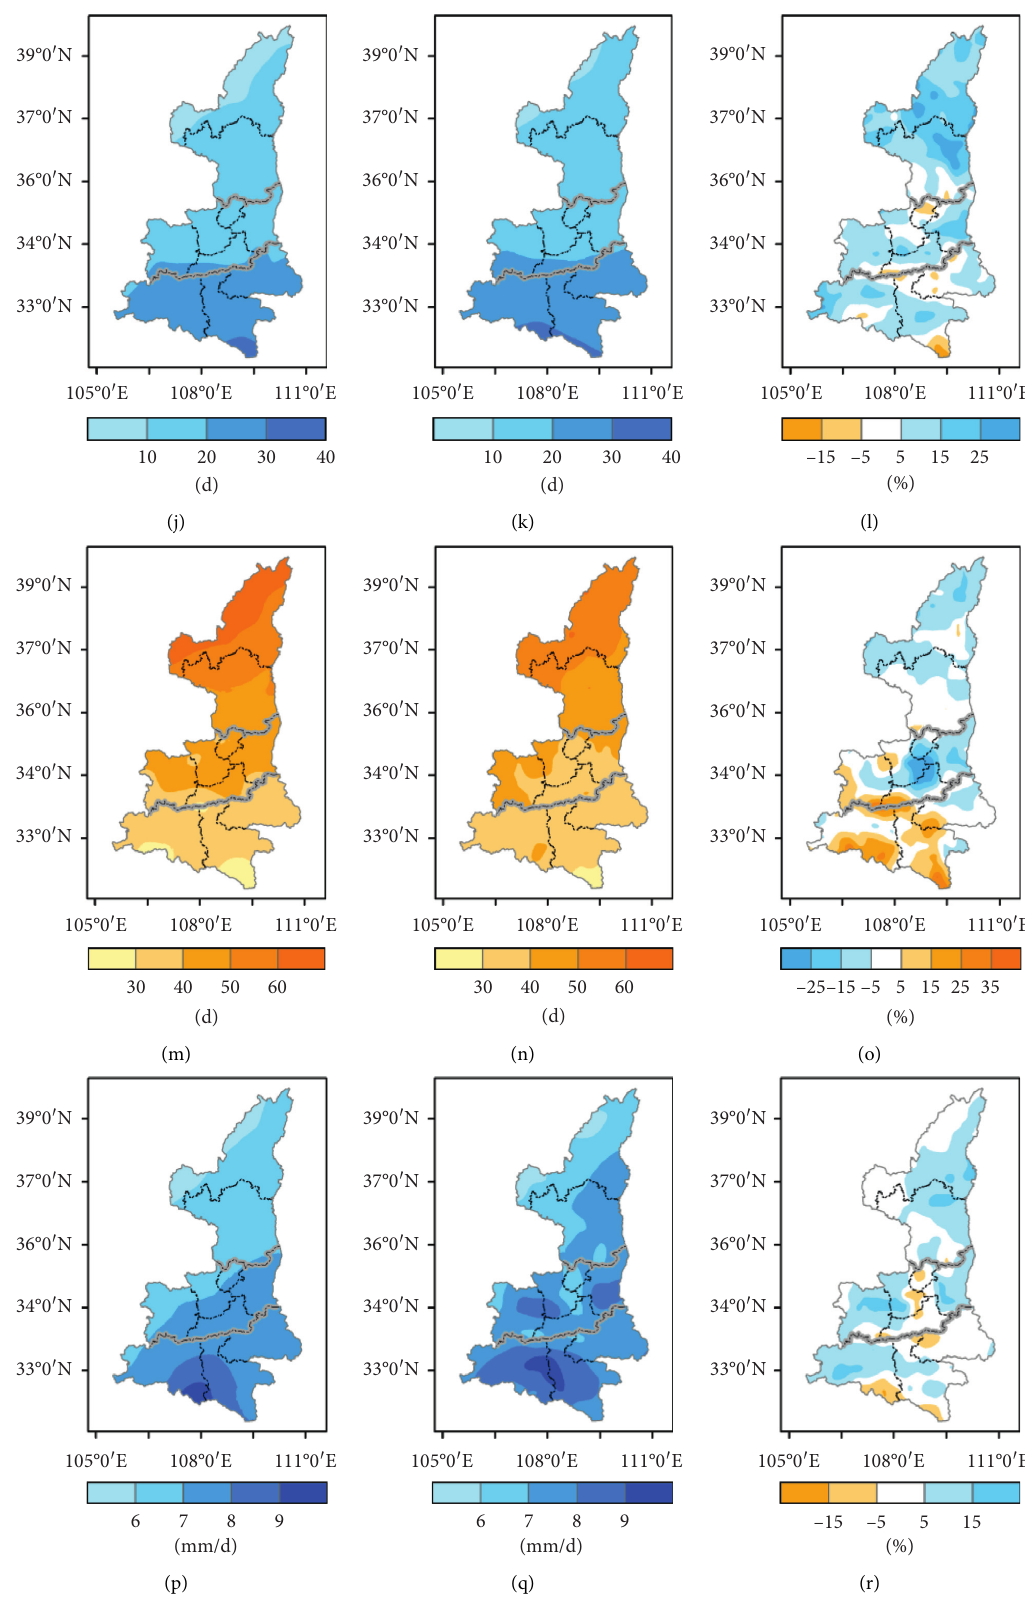
Figure 4: Spatial distribution of six annual mean EPIs over Shaanxi Province from 1986 to 2005. The left panels are for observed EPIs, the middle panels are for simulated EPIs, and the right panels are for the difference between simulation and observation. (a–c) Rx1day; (d–f) Rx5day; (g–i) R95p; (j–l) R10 mm; (m–o) CDD; (p–r)